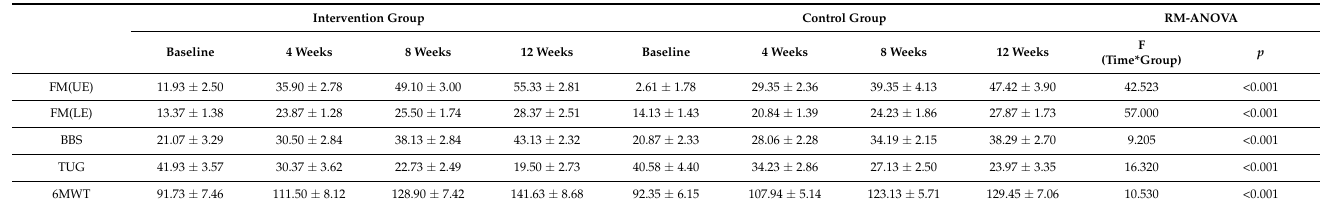
Table 4. Changes in scores of functional condition and motor control abilities after 4, 8 and 12 weeks of telerehabilitation